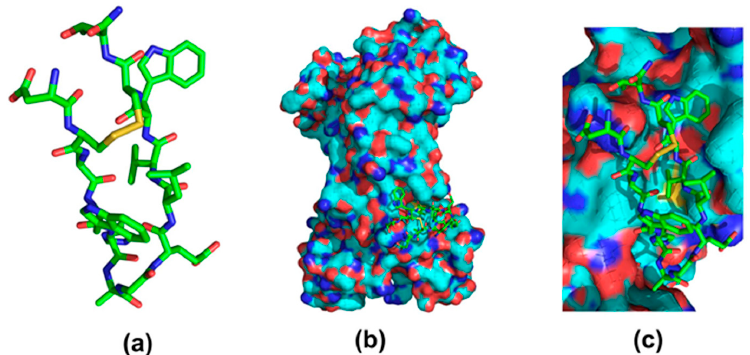
Figure 3. Structure of Fc-III binding to the Fc-region of IgG. ( a ) Fc-III (DCAWHLGELVWCT-NH 2 ); ( b ) Full view; ( c ) close view. Pymol generated image from a PDB file (1DN2).